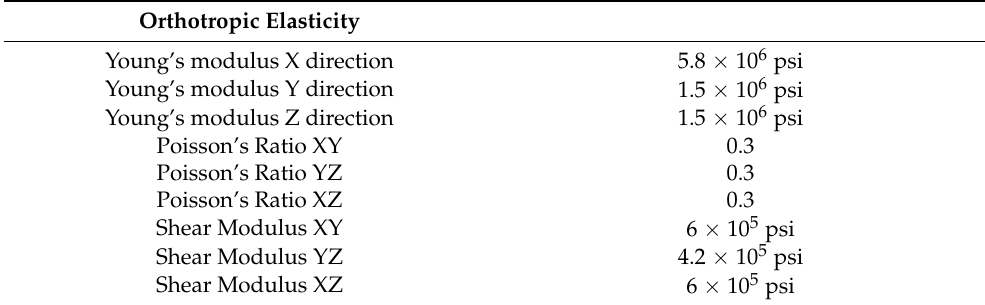
Table 1. The material properties of the elastic